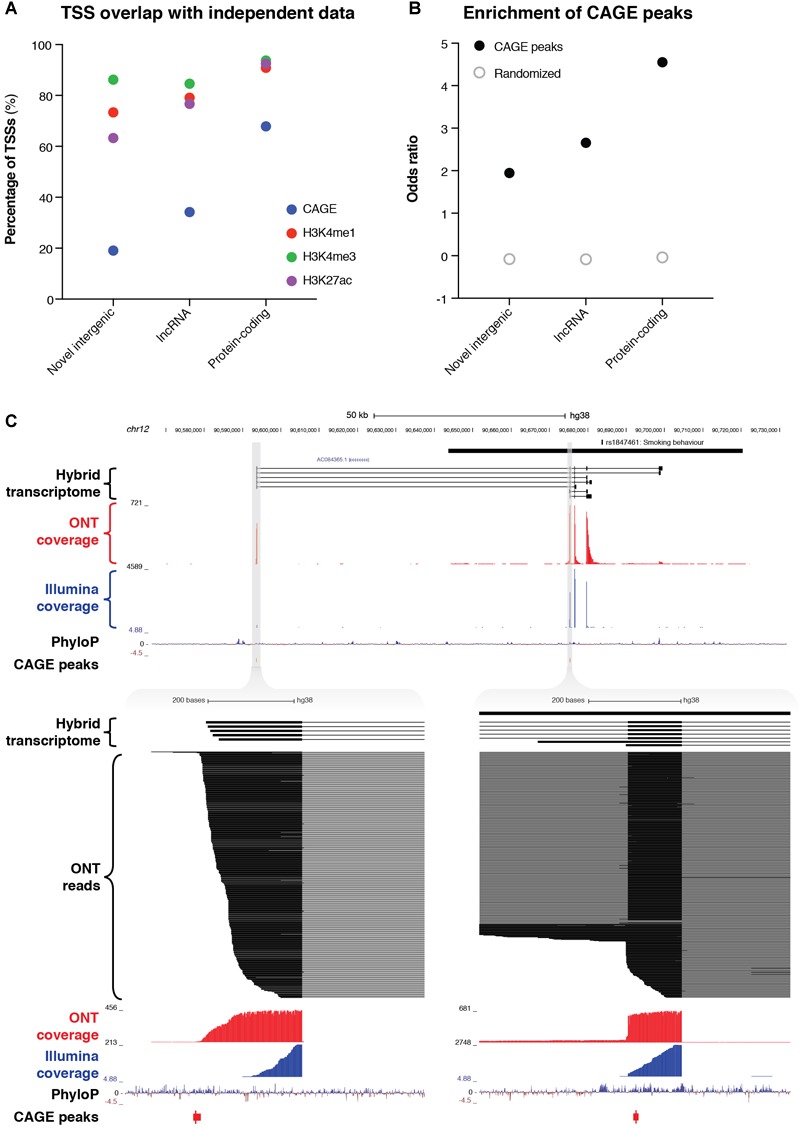
Identification of novel intergenic transcripts. (A) Bar charts indicate the fraction of transcription start sites (TSSs) occupied by cap analysis of gene expression (CAGE) peaks (blue), as well as the three epigenetic marks that are typically associated with actively transcribed promoters: H3K4me1 (red), H3K4me3 (green), and H3K27ac (purple). GENCODE (v29) lncRNAs and protein-coding genes are also plotted for reference. (B) Bar charts show the enrichment of the promoter regions of transcripts for CAGE peaks. Odds ratio of enrichment is plotted for novel intergenic transcripts compared to lncRNAs and protein-coding genes. (C, upper) Genome browser view shows a novel intergenic locus identified overlapping a GWAS haplotype block (solid black bar, top) associated with smoking behavior (rs1847461) on chromosome 12. Transcripts from our filtered hybrid transcriptome are shown below, followed by spliced ONT sequencing coverage (red), spliced Illumina sequencing coverage (blue), PhyloP conservation track, and CAGE robust peaks. (C, lower) Two separate magnified views show novel TSSs supported by CAGE peaks and highly conserved promoter regions. ONT read alignments are also shown.